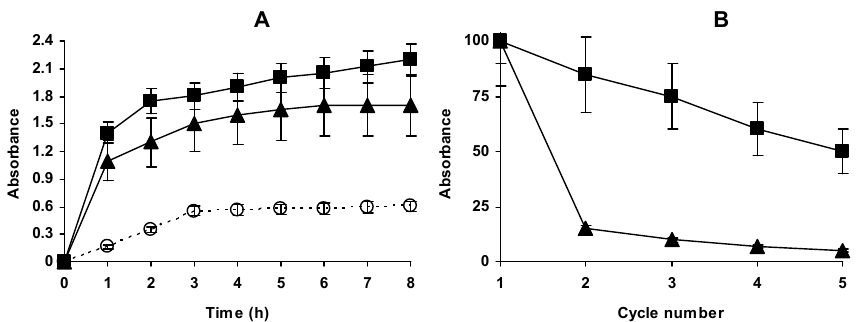
8 of 15 Figure 6. Effect of different glutaraldehyde modifications of Glx-AL-EDA on the inactivation courses at pH 7 and 54 °C. Other specifications are described in methods section. Open circles: aminated enzyme, Solid circles: aminated enzyme modified at pH 7 for 1 h with glutaraldehyde and then reduced; Solid Triangles: aminated enzyme modified with glutaraldehyde at pH 7 for 1 h and then incubated 3 h at pH 8 before reduction, Solid Squares: aminated enzyme modified at pH 7 with glutaraldehyde for 1 h and then incubated at pH 9 for 3 h before reduction. Considering in a global way activity and stability, we decided to characterize the modified enzyme incubated at pH 9. Figure 7 shows that the stabilization found at pH 7 could be also detected at pH 9, with very similar values. However, at pH 4 the stabilization was significantly lower (with 30% of activity retention after 6 h for the no modified enzyme and 50% for the modified enzyme). Figure 7. Effect of glutaraldehyde treatment on the stability of immobilized and aminated under different conditions. Glx-AL-EDA was modified at pH 7 with glutaraldehyde and then incubated at pH 9 for 3 h before reduction. Inactivation courses were studied at pH 4 and 44 °C ( A ) and at pH 9 and 58 °C ( B ) Open circles: Glx-AL-EDA, Solid Squares: Glx-AL-EDA-GLU. 2.6. Hydrolysis of Casein Using Glx-AL-EDA-GLU Casein hydrolysis using Glx-AL-EDA-GLU at 50 °C was 30% slower than using Glx-AL (results not shown). However, Figure 8 shows that at 69 °C, Glx-AL-EDA-GLU was 10% more active than Glx-AL and much more active than the free Alcalase. In fact, the free enzyme stopped the reaction far from the hydrolysis level reached by the immobilized preparations, while Glx-AL-EDA-GLU offered a more lineal course. This suggested that the Glx-AL preparation was distorted at this high temperature and for this reason the reaction was stopped before reaching the maximum value. To see if there was a relation between this lower activity and enzyme operational stability, both